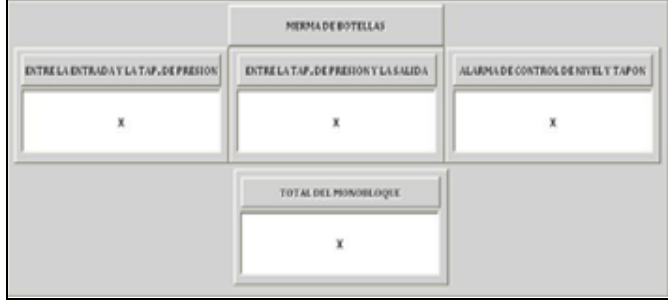
Figura 4: Conteo de botellas en el monobloque. Fuente: Los Autores, (2018).